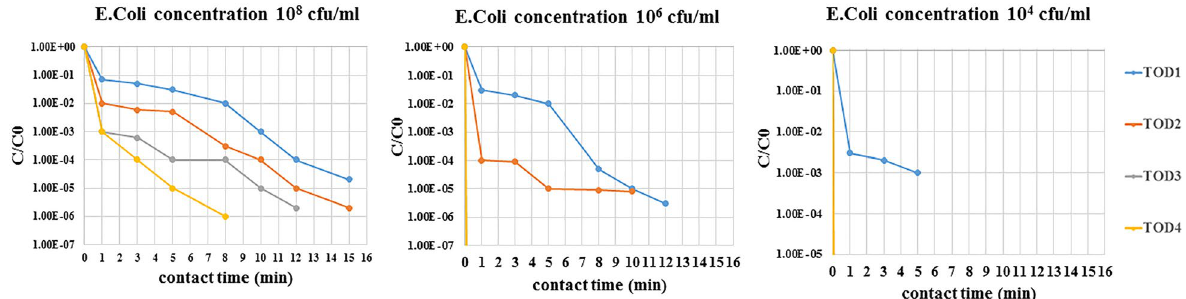
Figure 2. Removal efficiencies of antibiotic-resistant Escherichia coli by ozonation at ozone doses of 11–45 mg/l (TOD1 = 11 mg/l, TOD2 = 25 mg/l, TOD3 = 37 mg/l, TOD4 = 45